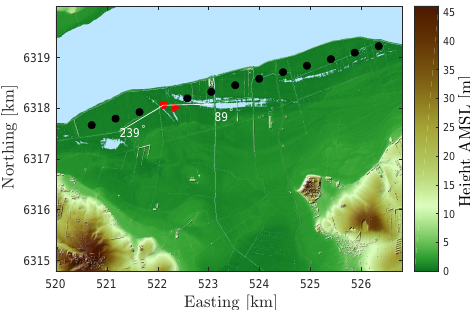
Figure 6. The Nørrekær Enge wind farm in northern Denmark on a digital surface elevation model (UTM32 WGS84). The wind tur- bines are shown in circles, that with the nacelle lidars in red and the mast in a triangle. The sector used for the analysis is also indicated. The waters of Limfjorden are shown in light